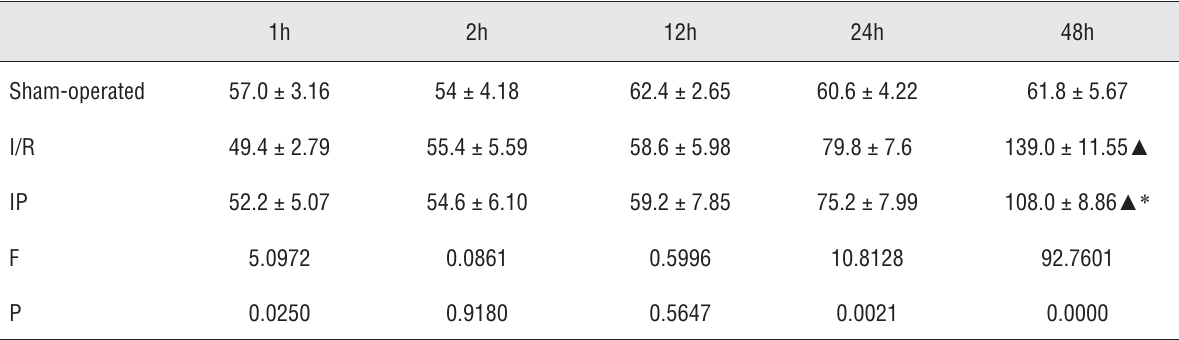
Table 5 - Changes of serum creatinine after renal ischemic preconditioning (umol/L). 1h 48h